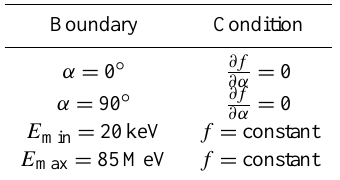
Table 1. BAS model boundary